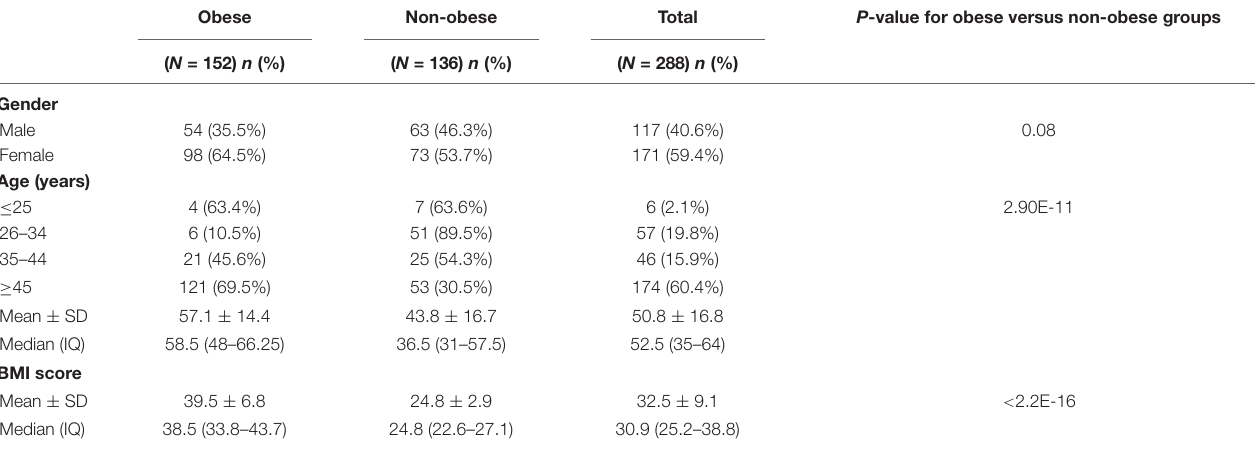
TABLE 1 | Clinical characteristics of the Kuwaiti study samples.